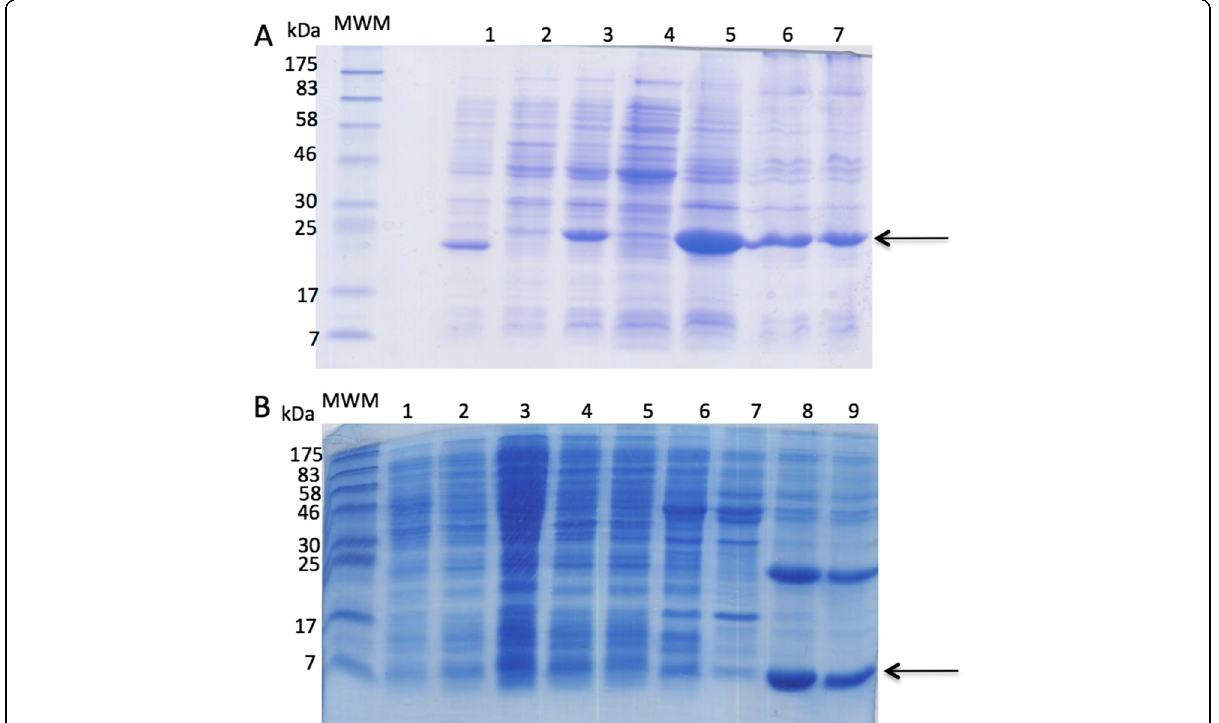
Fig. 2 SDS-PAGE showing the expression of pQE40HisrDHFRBa1 or pET28HisrBa1. a Gel of pQE40HisrDHFRBa1 expression. Left lane shows the molecular weight markers (MWM). Lane 1, cells with vector pQE40; lane 2, cells without IPTG induction; lane 3, cells with IPTG induction; lane 4, supernatant; lane 5, inclusion bodies; lanes 6 and 7, DHFR-Ba after affinity chromatography. b Gel of pET28HisrBa1 expression. Left lane shows the molecular weight markers (MWM). Lane 1, cells without IPTG induction; lane 2, cells with IPTG induction; lane 3, supernatant; lane 4, inclusion bodies; lanes 5, first affinity chromatography elution; lanes 6 and 7, first and second wash with 20 mM Imidazol; l 8 and 9, HisrBa1 after